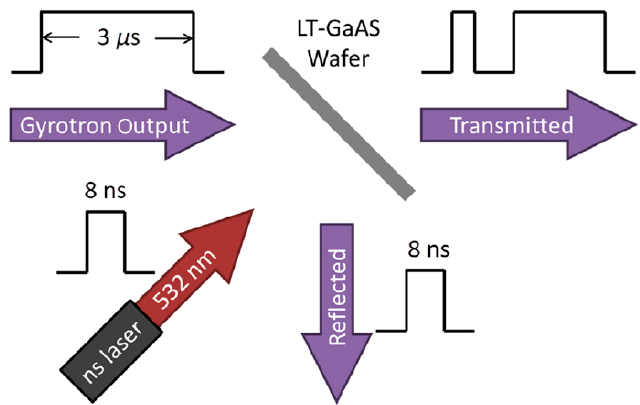
Figure 5. Schematic of the LDSS and basic parameters used in [60]. Reprinted with permission from Ref. [60]. Copyright 2019 American Physical Society. Input laser pulse: 215 mJ, 6 ns, peak intensity at wafer 3.5 MW/cm 2 , energy density 15.3 mJ/cm 2 ; incident gyrotron pulse 525 kW, 3 µs; output pulse 410 kW, 9 ns.